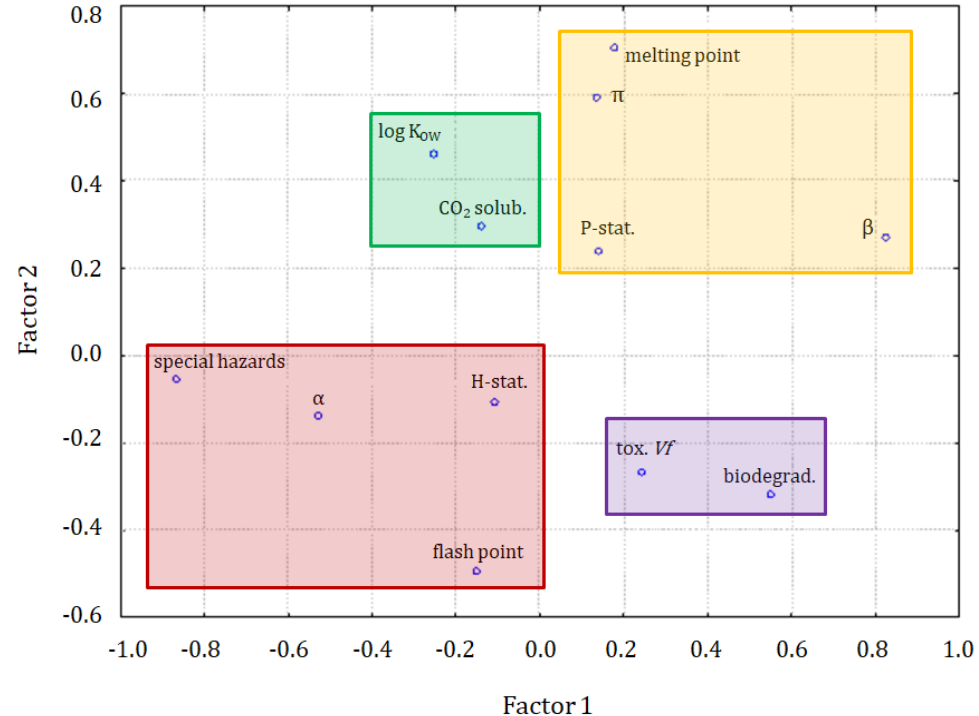
Figure 6. The plot for 3 latent factors.